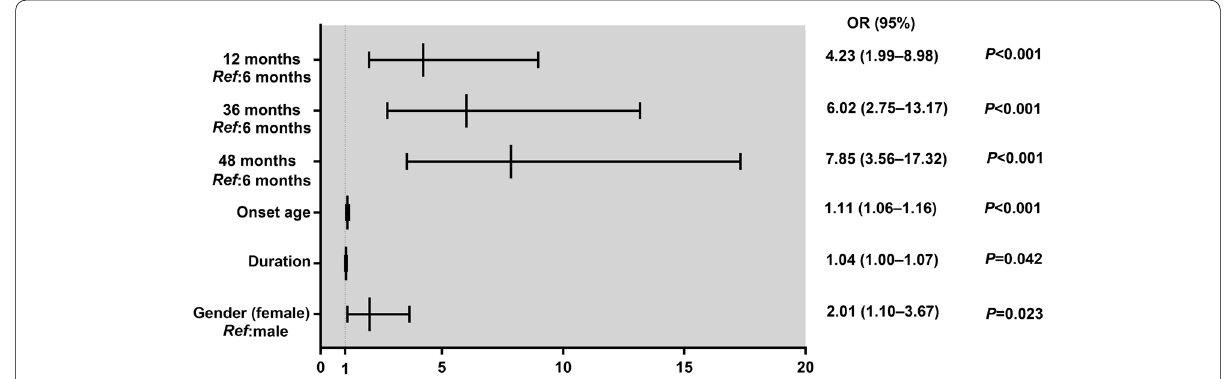
Fig. 1 The prognostic factors for VNS outcome. Ref: reference